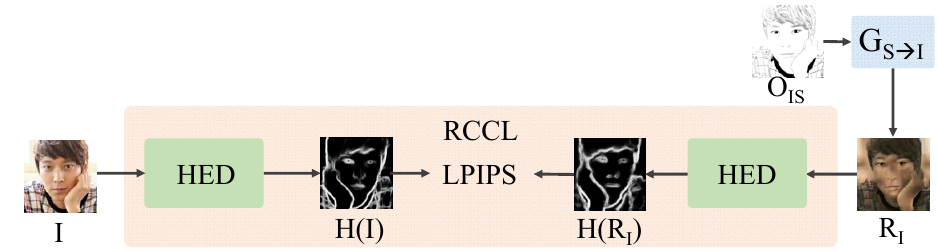
Figure 6. The structure of our RCCL module.